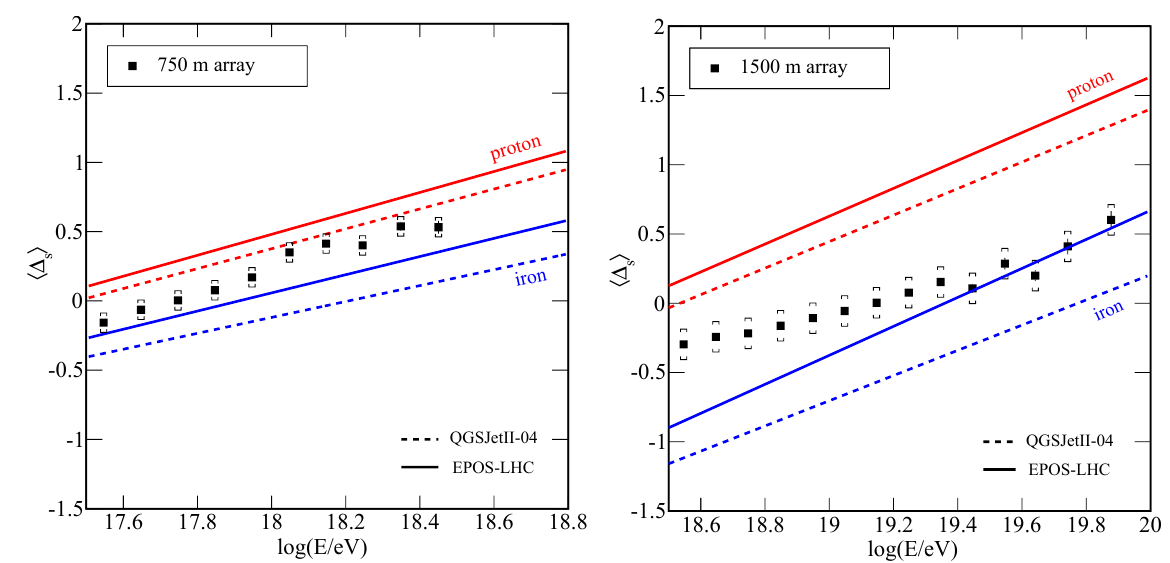
Figure 11. (cid:104) ∆ s (cid:105) as a function of the energy for the two surface arrays. Brackets correspond to the systematic uncertainties. Data are compared to the predictions obtained from simulations.